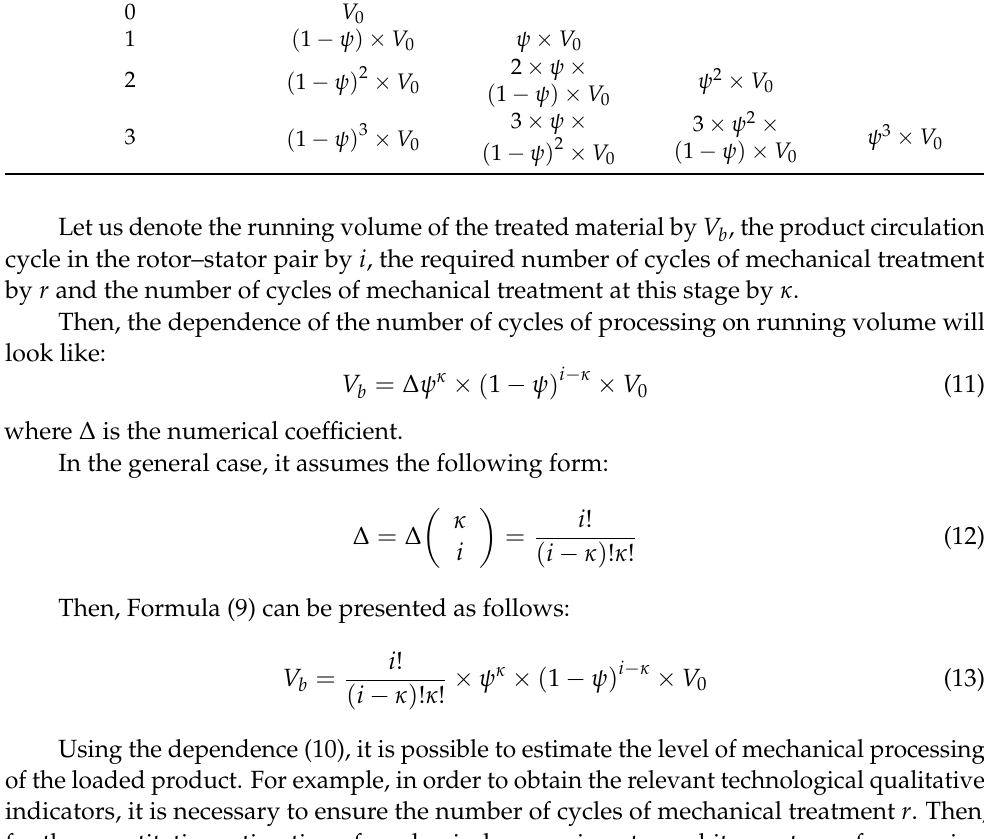
Table 2. Mechanical processing of the product in the rotor–stator pair depending on its circulation. Mechanical Processing of the Product (Number of Circulation Cycle